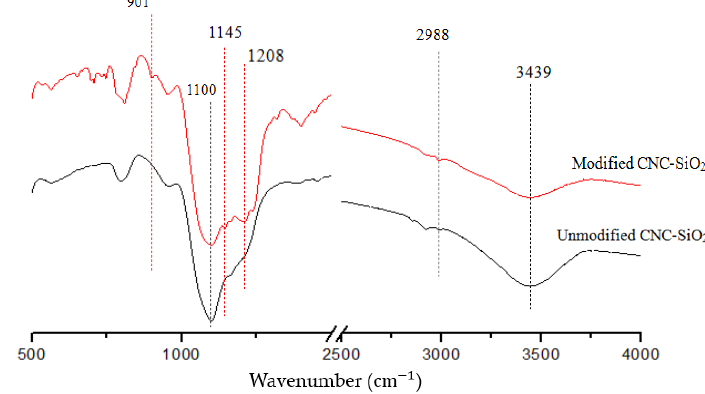
Figure 4. FTIR of CNC-SiO 2 rods before and after modification.